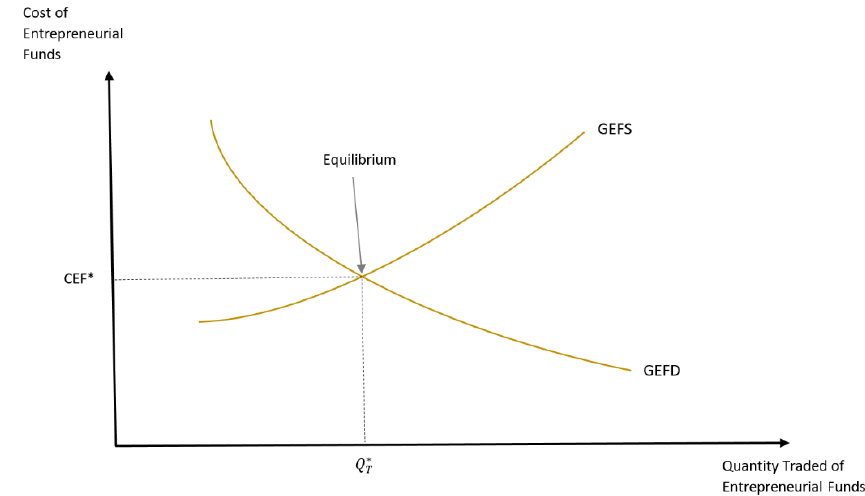
Figure 2. Global Entrepreneurial Finance Market (GEFM).